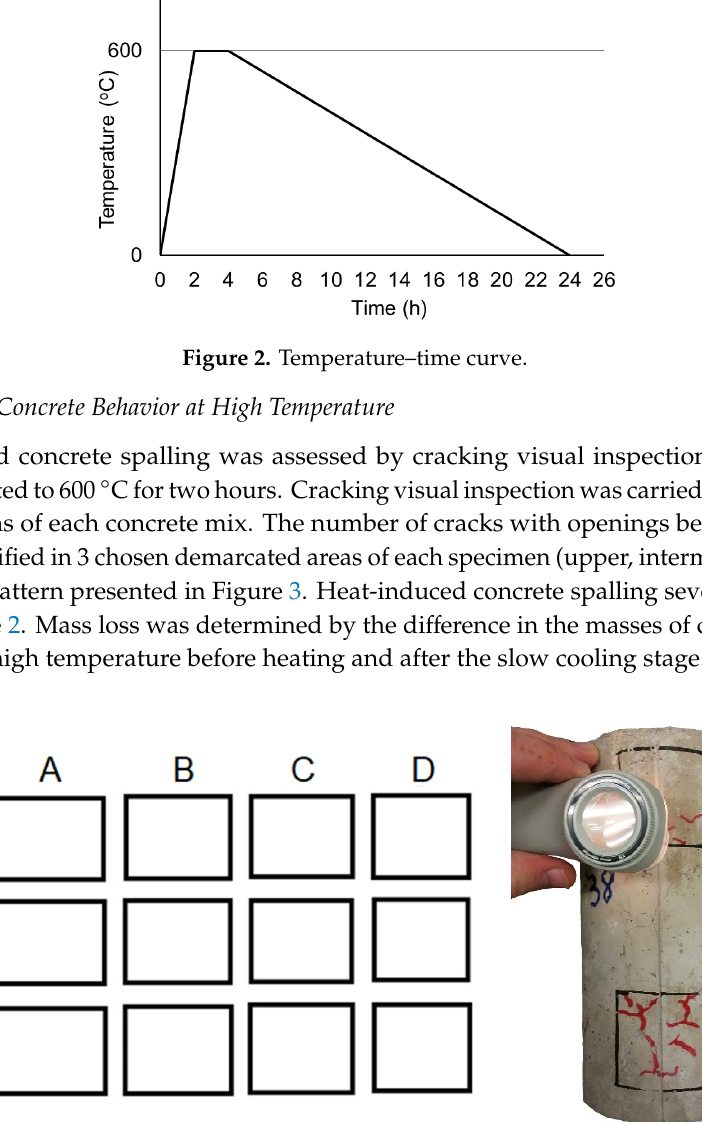
Figure 3. Cracking visual inspection pattern. Table 2. Spalling classification.